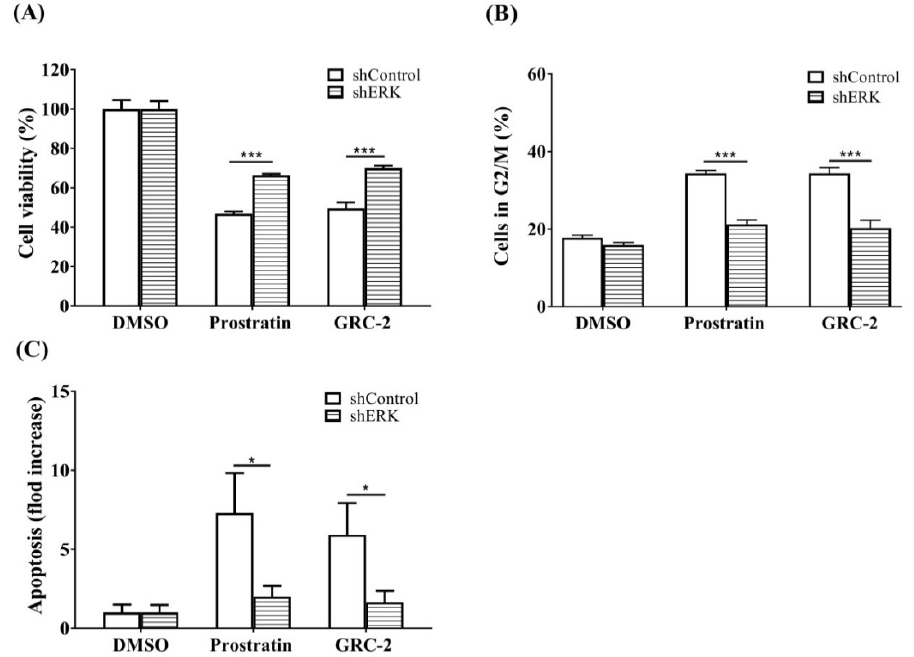
Figure 6. Knockdown of ERK attenuates the cytotoxicity of prostratin and GRC-2 in A549 cells. The ERK knockdown A549 cells were treated with DMSO, prostratin (3 μ M) or GRC-2 (300 nM) for 72 h. ( A ) The cell viability, ( B ) cell cycle, and ( C ) apoptosis were measured by MTT assay, PI staining and annexin V/PI staining, respectively. The data from ( C ) are presented as fold increases in late apoptosis compared to the control vector. Results are presented as mean ± S.E.M. ( n = 3) * p < 0.05 and *** p < 0.001 as compared with the respective control.